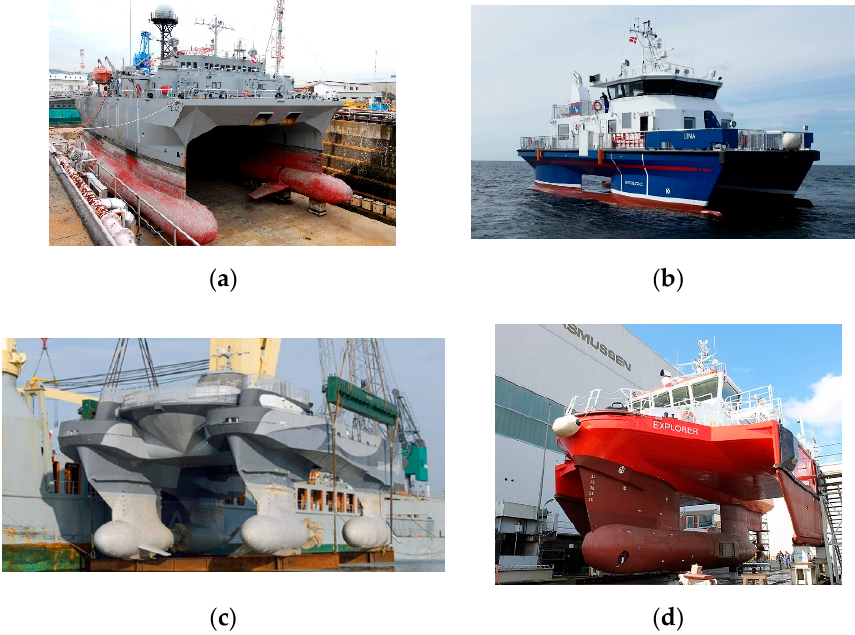
Figure 2. Sample photos of SWATH ships: ( a ) SWATH GEN. I [46], ( b ) SWATH GEN. II [47], ( c ) SWATH GEN. III [48], ( d ) SWATH GEN. IV–SWASH [49].